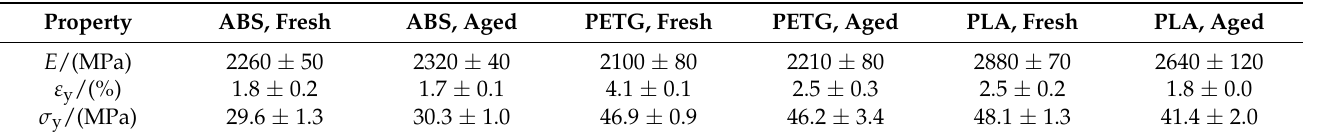
Table 5. Elastic modulus, E , yield strength, σ y , and elongation at yield, ε y , of the polymers in the fresh and aged (100 days) state.